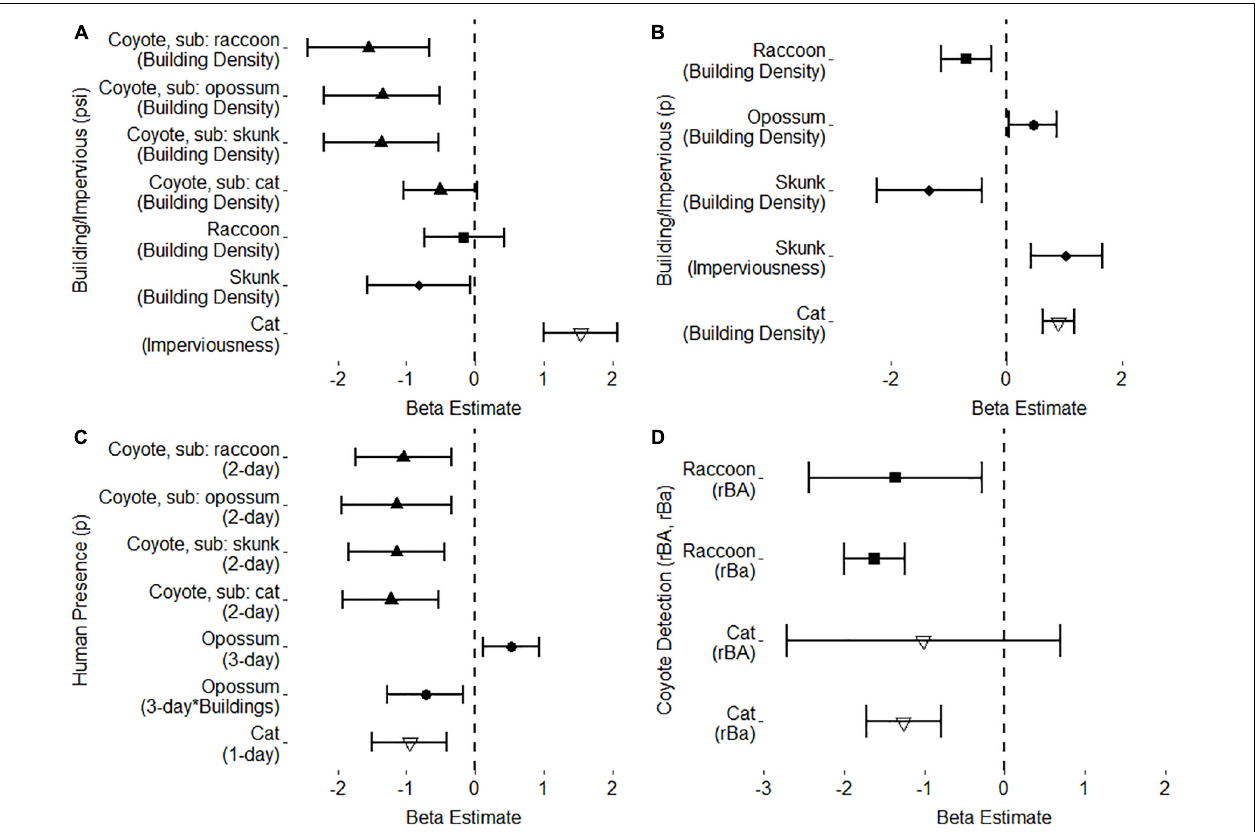
FIGURE 3 | Beta estimates and 95% confidence intervals for top two-species occupancy models. Beta estimates that cross the dashed line at 0 are not considered significant. (A) Top urbanization covariates, building density and imperviousness, for mesopredator occupancy. (B) Top urbanization covariates, building density and imperviousness, for mesopredator detection. (C) Top human presence covariates for mesopredator detection as well as an interaction term for human presence across building density for opossum detection. (D) Raccoon and cat detection variables for when coyotes are present and detected (rBA) and present but not detected